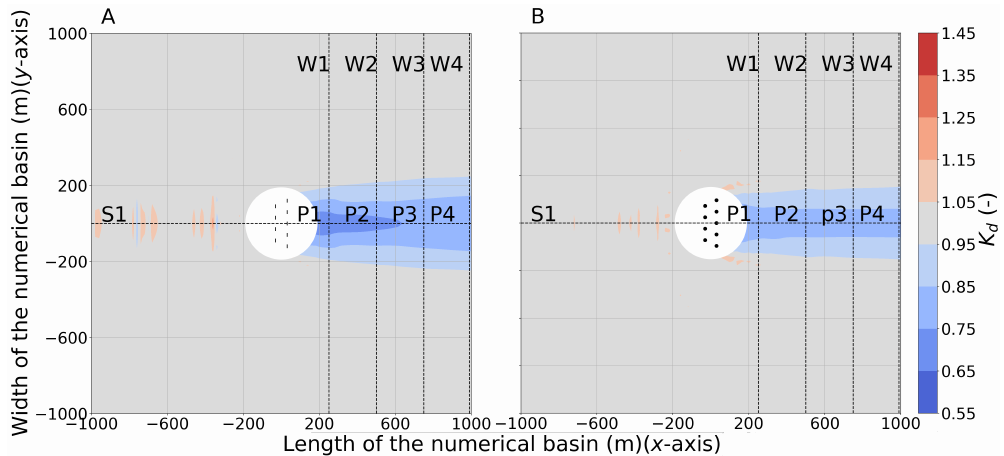
Figure 10. K d disturbance coefficient results for a 9-OSWEC array (O2) ( A ) and a 9-HCWEC array (H2) ( B ) interacting with long-crested irregular waves with H s = 2.0 m, T p = 8.0 s and s 1 = 0.0 ◦ . The coupling region is filled using a white solid circle which includes the WEC (indicated by black solid circles). Incident waves are generated from the left to the right. S1, W1, W2, W3, and W4 indicate the locations of